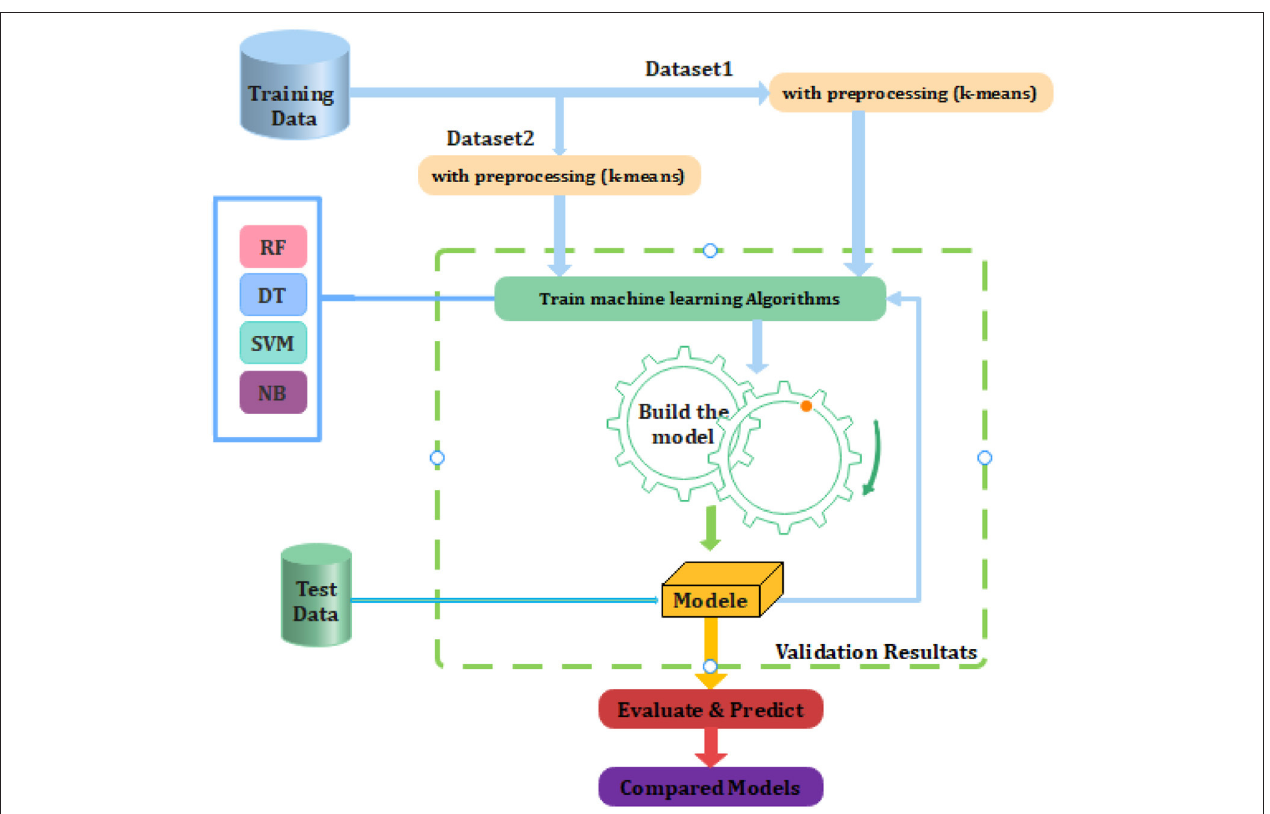
FIGURE 1 | Proposed model